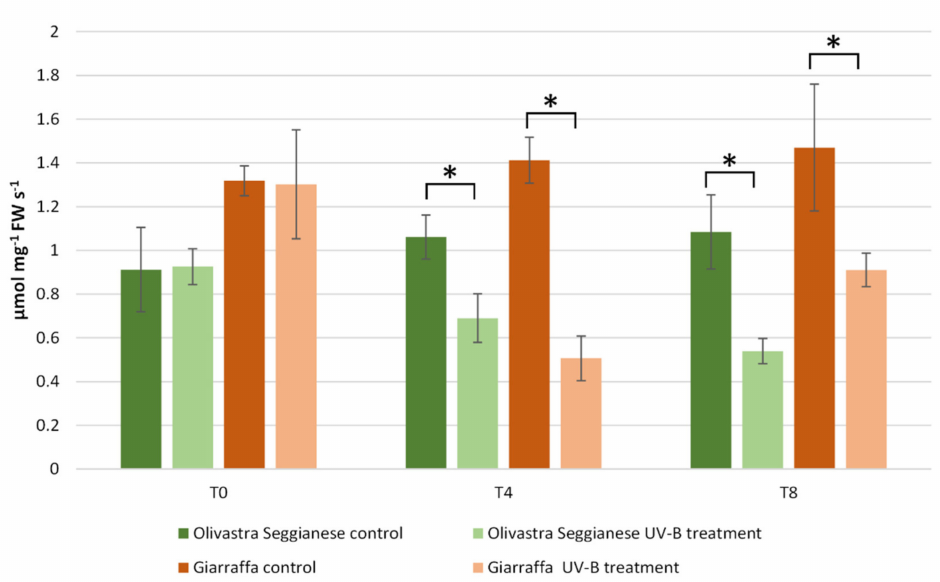
Figure 6. RubisCO activity in Giarraffa and Olivastra Seggianese leaves under control conditions and after exposure to UV-B treatment. The X -axis indicates the treatment times. The asterisks (*) indicate statistically significant differences between control and stressed samples within each variety. The two varieties differ by ANOVA test for p ≤ 0.01. Values are mean ± standard ( n =